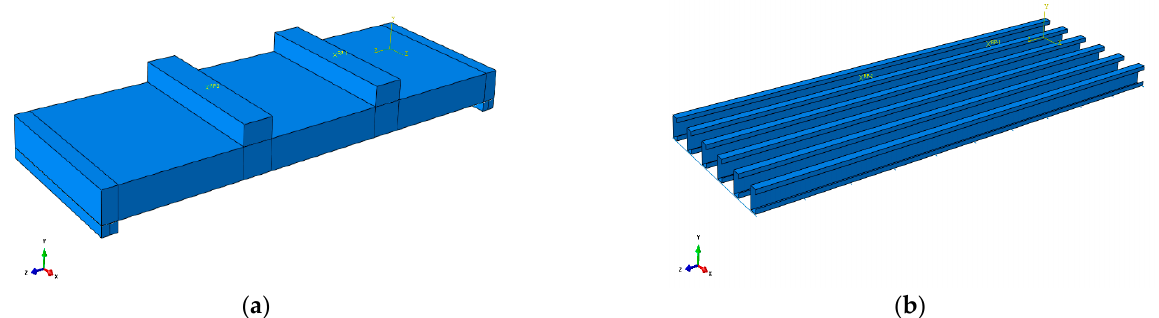
Figure 10. One-way slab model of lightweight steel and foam concrete. ( a ) The composite slab with loading beams and support; ( b ) Cold-formed thin-walled C steel channels with steel belts.